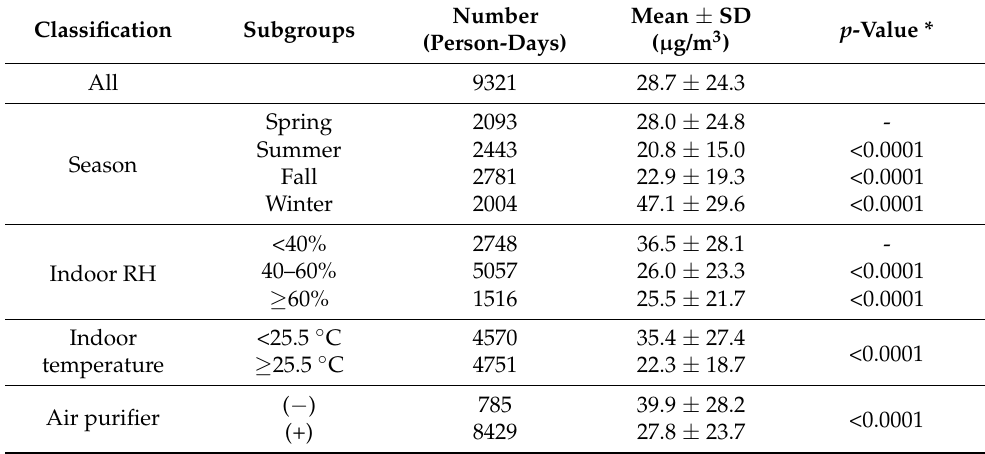
Table 2. Summary of indoor PM 2.5 concentration by season and indoor environments ( n = 64).